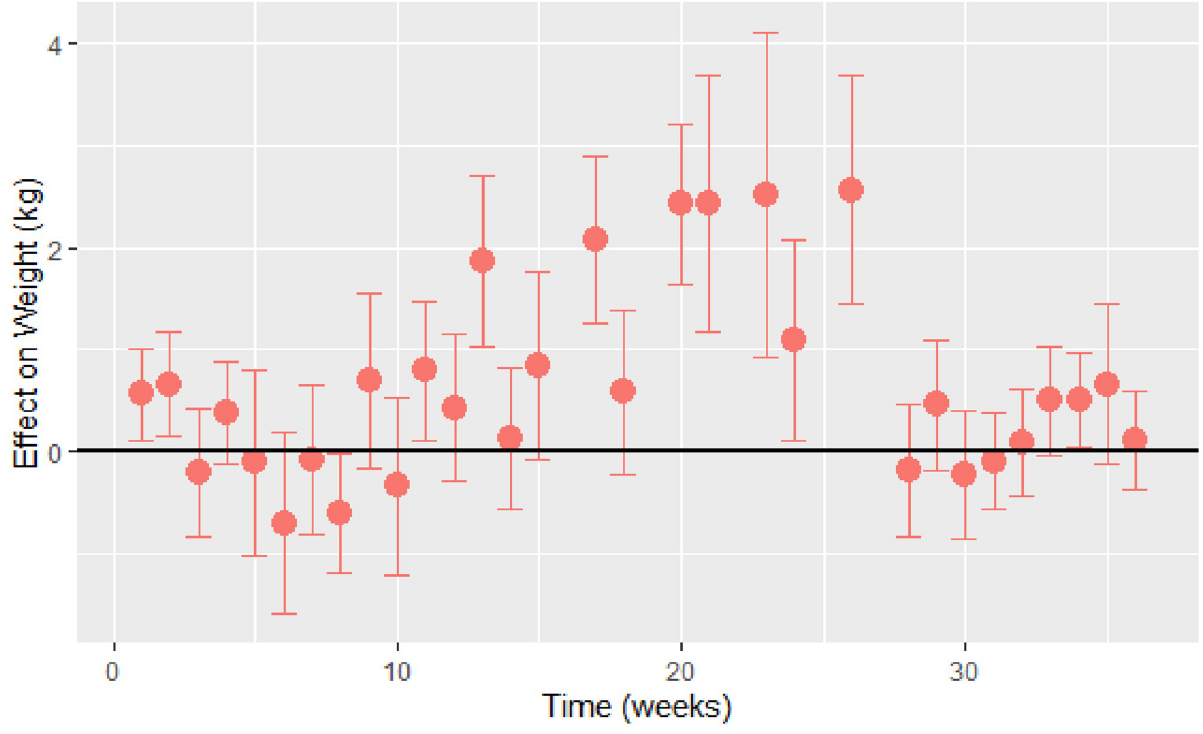
Fig 1. Estimated time-varying effects of Ramadan on weight using the discrete model. Effect on Weight (kg). Time (weeks).